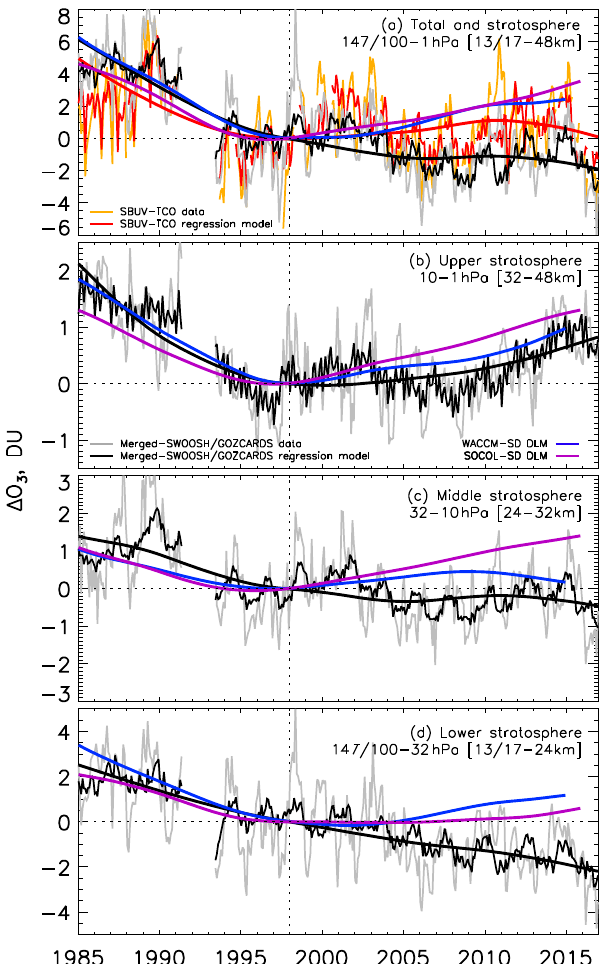
Figure 3. Total and partial column ozone anomalies inte- grated over 60 ◦ S–60 ◦ N between 1985 and 2016. Deseasonalised and regression model time series are given for the Merged- SWOOSH/GOZCARDS composite (grey and black, respectively) for (a) the whole stratospheric column and (b) upper, (c) middle, and (d) lower stratospheric partial column ozone. The DLM non- linear trend is the smoothly varying thick black line. In (a) , the deseasonalised SBUV total column ozone is also given (orange), with the regression model (red) and the non-linear trend (thick, red). Data are shifted so that the trend line is zero in 1998. DLM results for WACCM-SD (blue) and SOCOL-SD (purple) from Fig. S11 are also shown; model results in (a) are for the stratospheric